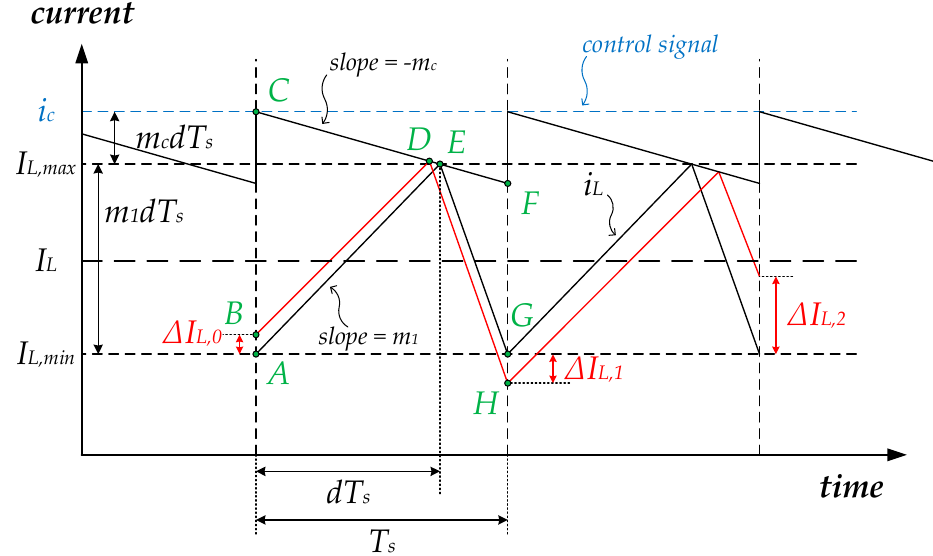
Figure A1. Schematic diagram of the peak current control technique with the addition of an improperly calculated compensation ramp.